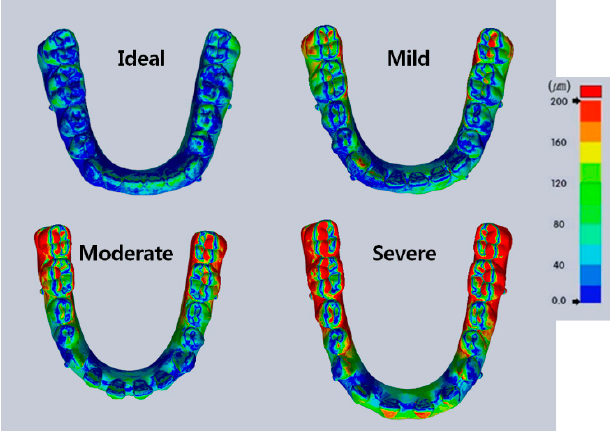
Figure 7. Representation of deviations when using iTero ® . The color map was set from 0 μ m to +200 μ m. Ideal: ideal dental arch; Mild: 1 mm spacing; Moderate: 3 mm spacing; and Severe: 5 mm spacing. Red represents areas of large deviations; Blue represents areas of small deviations. The deviation of Ideal is the smallest; that of Mild is larger than Ideal; that of Moderate is larger than Mild; and that of Severe is the largest, especially in the posterior area.